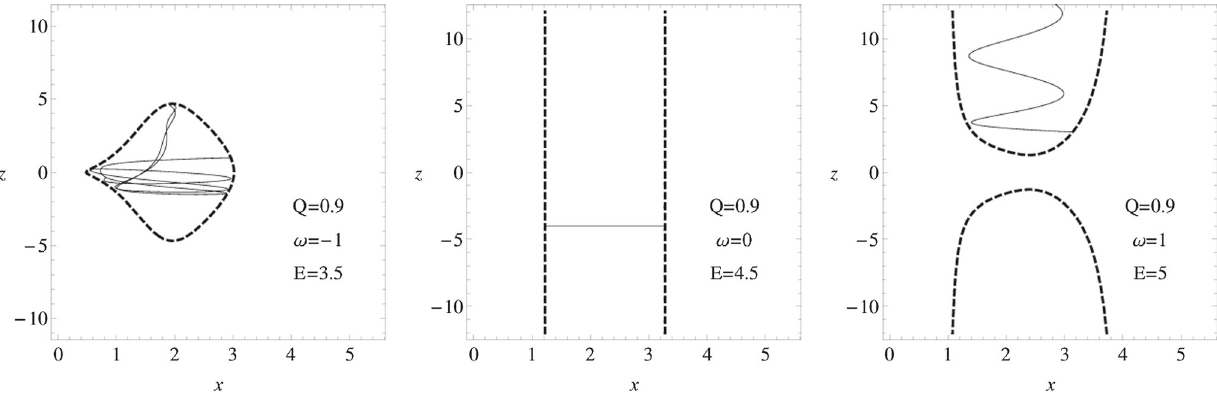
Fig. 3 Energy boundaries and the trajectories of the string loop with parameters J = 2 , Q = 0 . 9. For Fig. ω 1 = − 1 we have string energy E = 3 . 5 (left), for ω 1 = 0 E = 4 . 5 (middle) and for ω 1 = 1 E = 5